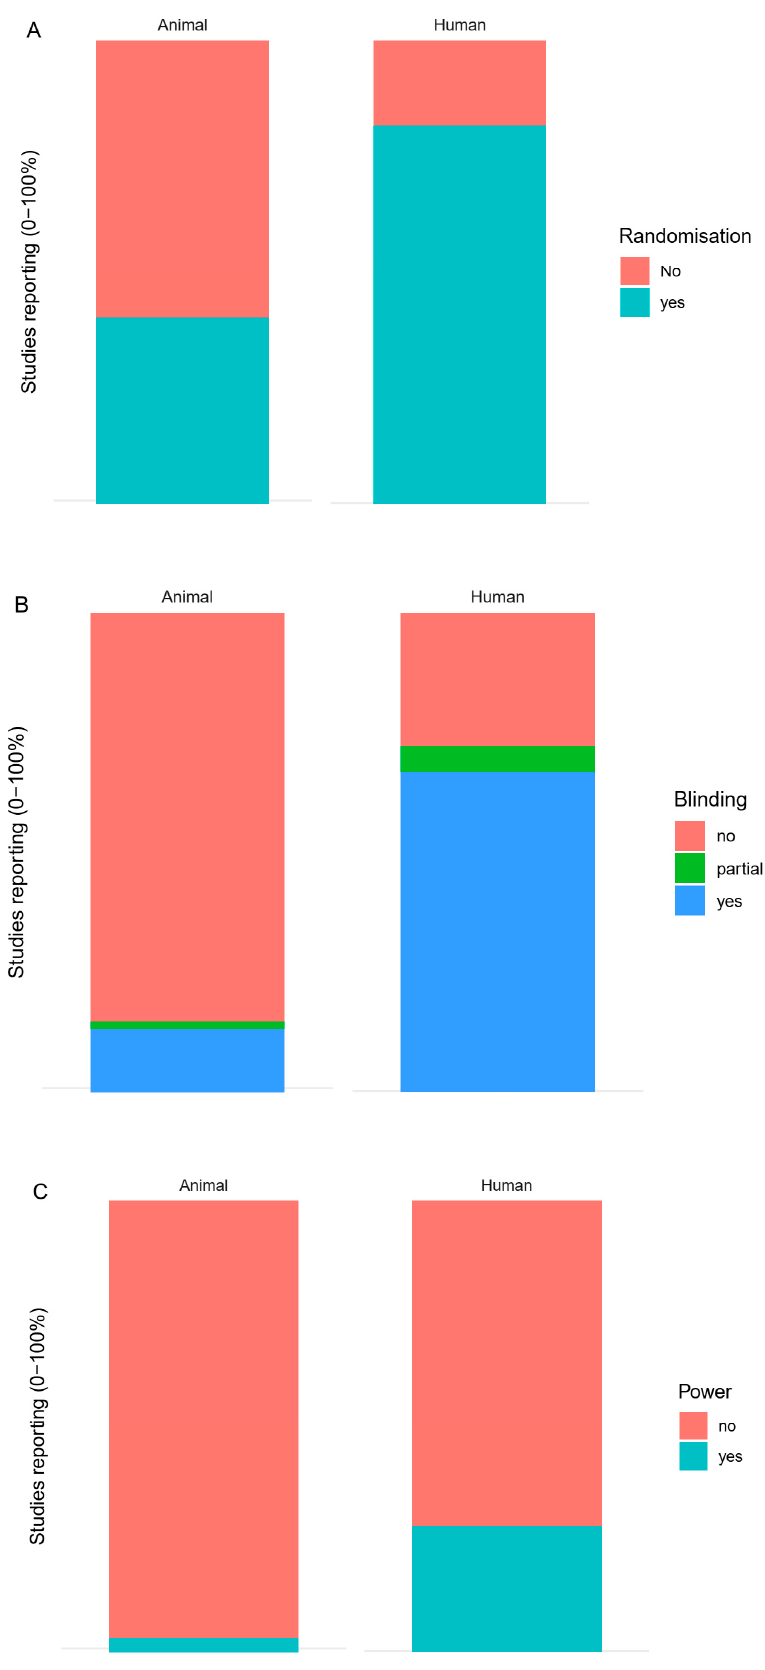
Figure 7. ( A ) Randomisation in animal and human studies; ( B ) blinding in animal and human studies; Figure 7. ( a) Randomisation in animal and human studies; ( b ) blinding in animal and human studies; ( C ) power calculations in animal and human ( c ) power calculations in animal and human studies.